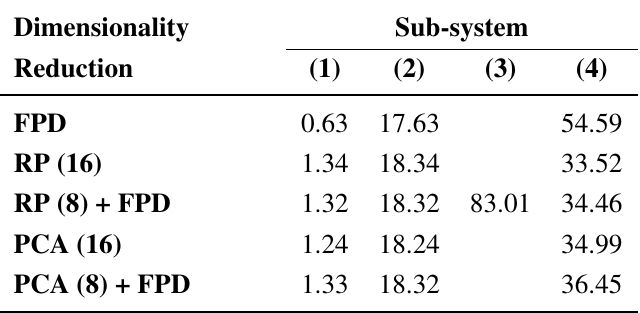
Table 3. Duty cycle (%) of the sub-systems identified in Figure 6. Tests performed on the IcyFlex WBSN running at 6 MHz.